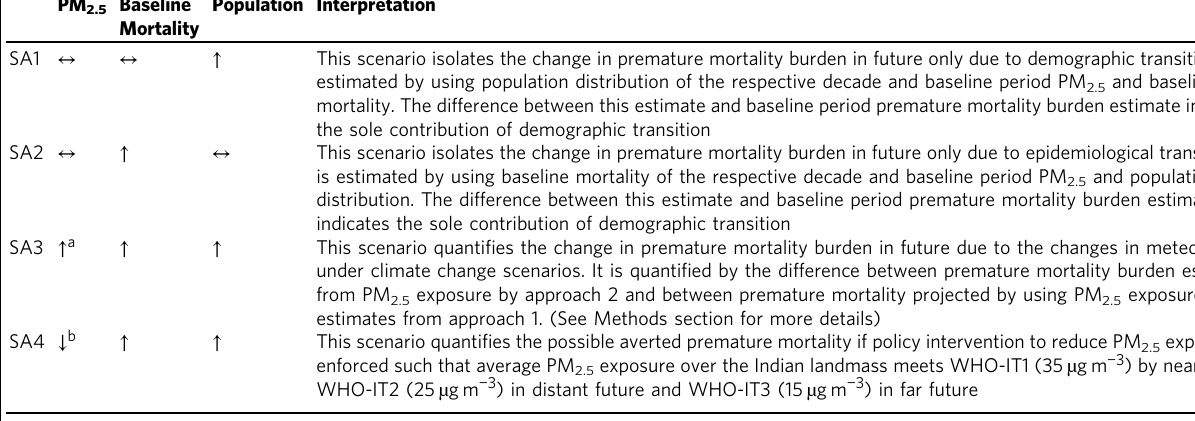
Table 2 Framework of the sensitivity study where the upward and downward arrows indicate an increase and decrease of the respective parameter relative to the baseline period in that particular sensitivity study while ‘ no change ’ is indicated by horizontal arrow PM 2.5 Baseline Population Mortality